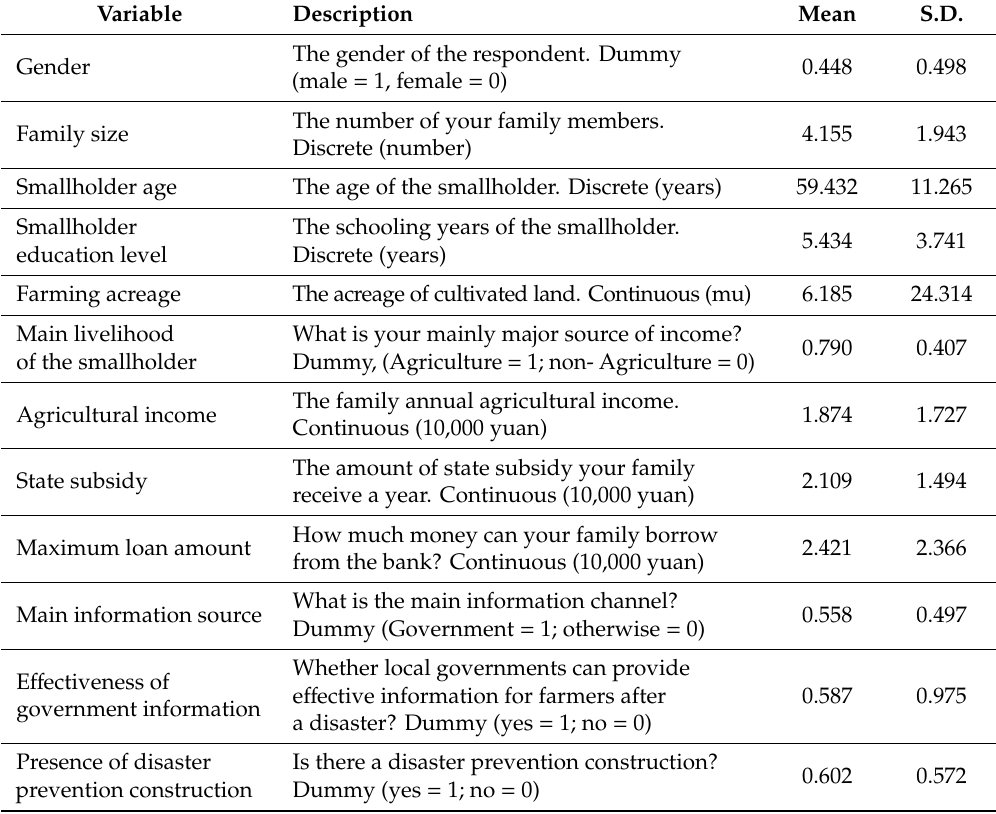
Table 1. Description of explanatory variables that a ff ect adaptation